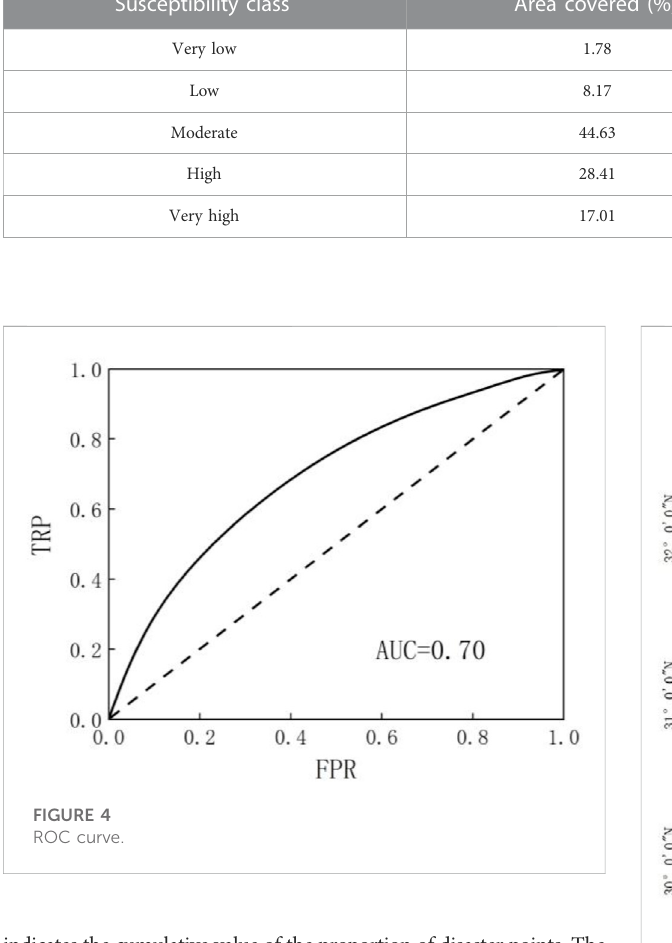
indicates the cumulative value of the proportion of disaster points. The AUC value represents the area between the ROC curve and the abscissa axis and, with values in the range of [0.5,1], it indicates the good fi tting